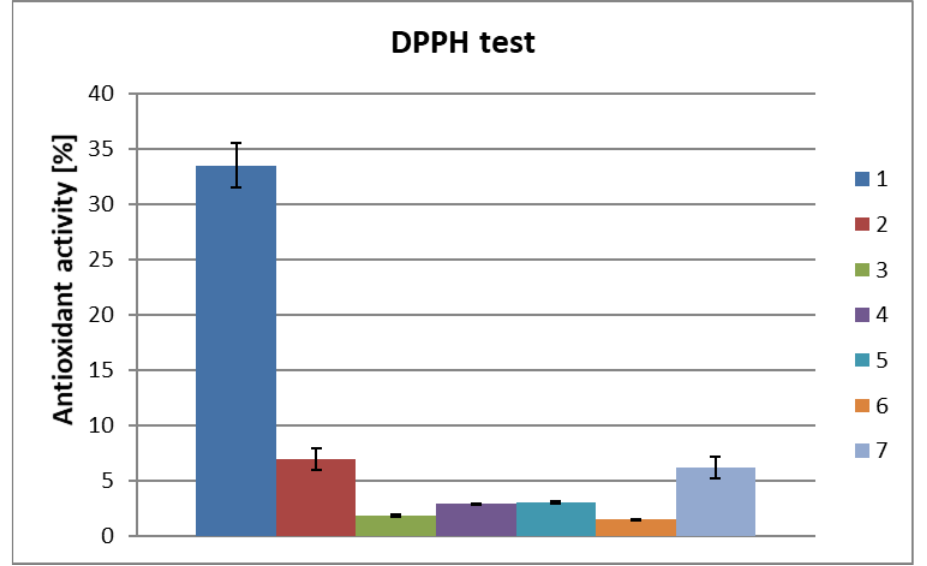
Figure 1. Antioxidant activity of hydrophilic (water and protein) fractions obtained from algae biomass: (1) ascorbic acid 1 nM (0.17 mg / mL); (2) water extract first repetition, c = 0.5 mg / mL; (3) water extract, second repetition, c = 0.2 mg / mL; (4) water extract, third repetition, c = 0.2 mg / mL; (5) protein fraction